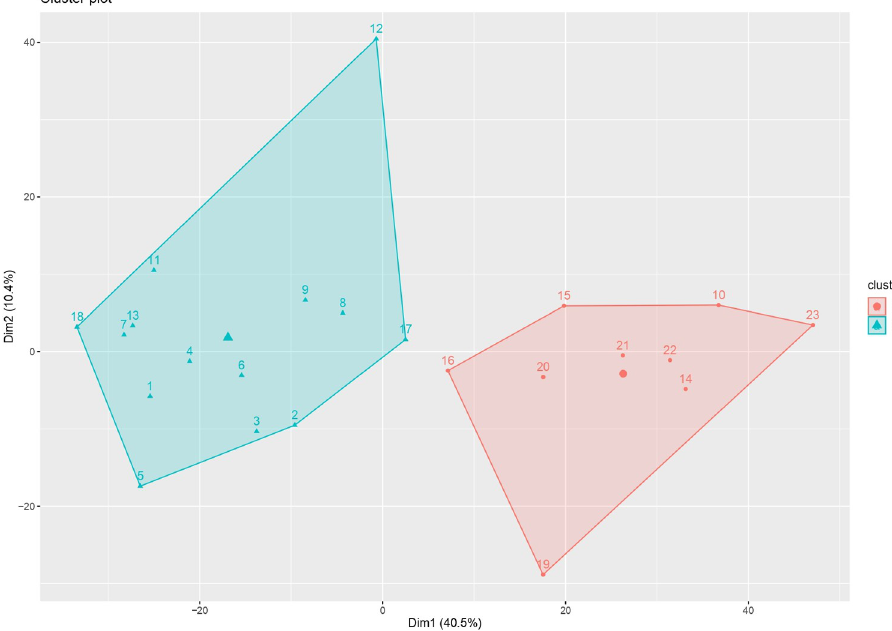
Fig 8. Cluster analysis of L vs L+P comparison. Numbers represent the pigs sampled and different colours indicate the clusters. Cluster 1 = L+P; Cluster 2 = L.